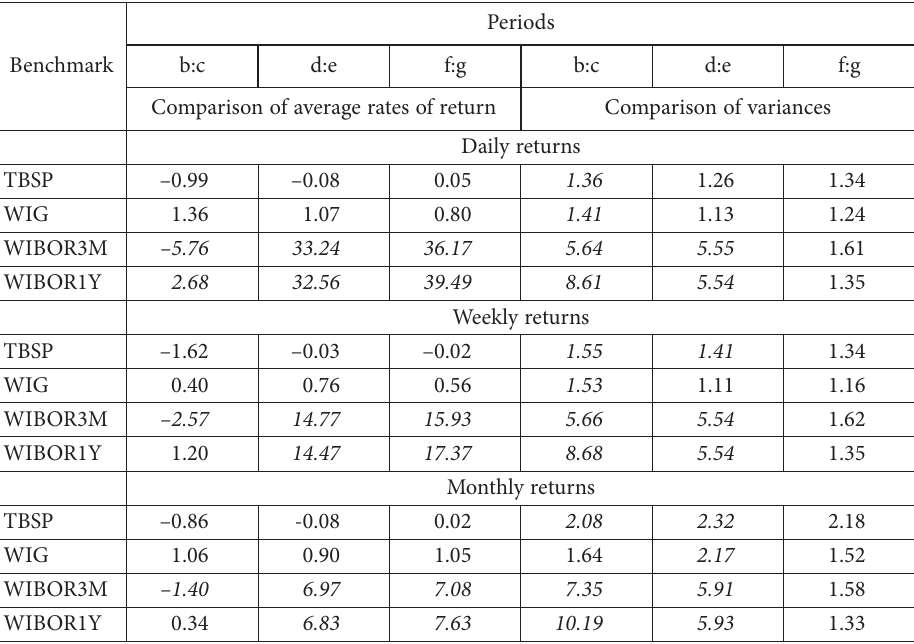
Table 2. Values of statistics (2), (3) verifying equality of returns and risks in two comparing periods (source: own calculations)